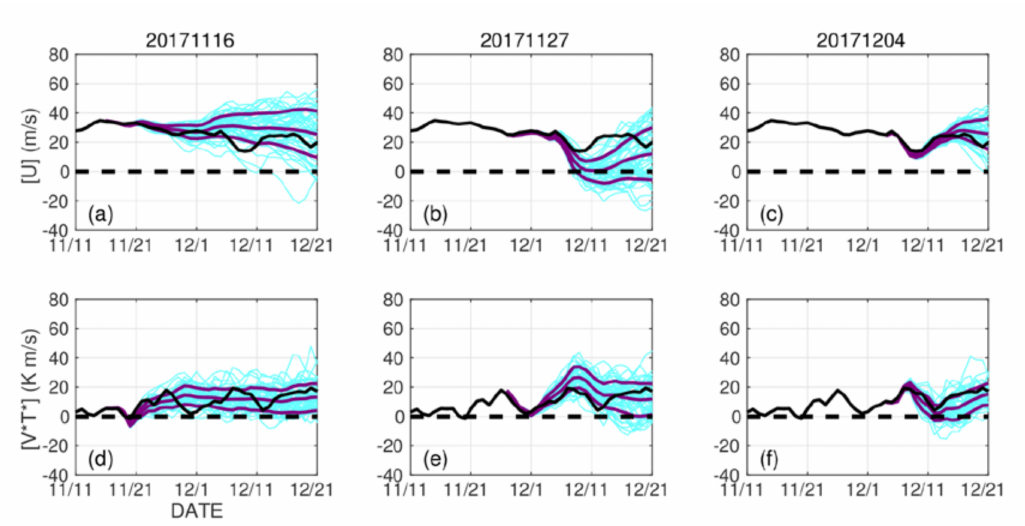
Figure 3. As in Figure 1, but for the target MSSW and comparison non-MSSW ensembles for the first cluster (Table 1). The initialization dates are indicated above the panels. Top panels ( a – c ) plot the zonal mean zonal wind, and bottom panels ( d – f ) plot the heat flux. Cyan lines are for all ensemble members. Purple lines plot the ensemble mean ± one standard deviation. Black line is for the JRA-55